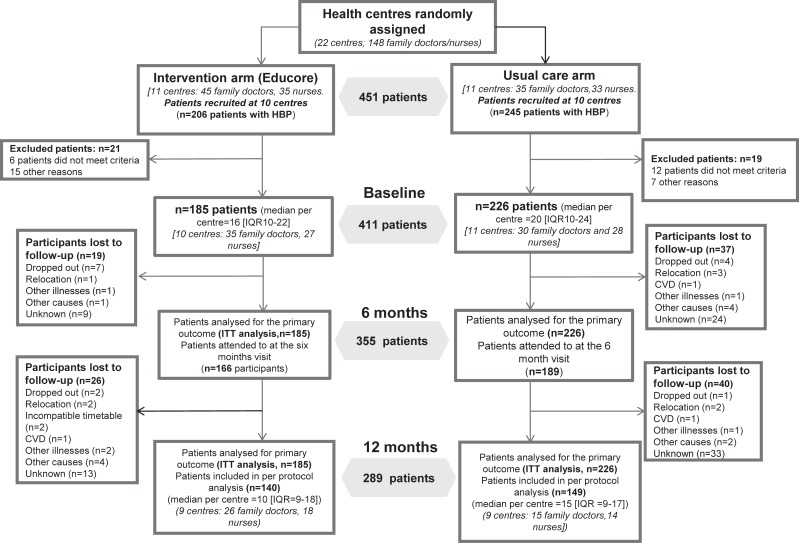
Study flow diagram.